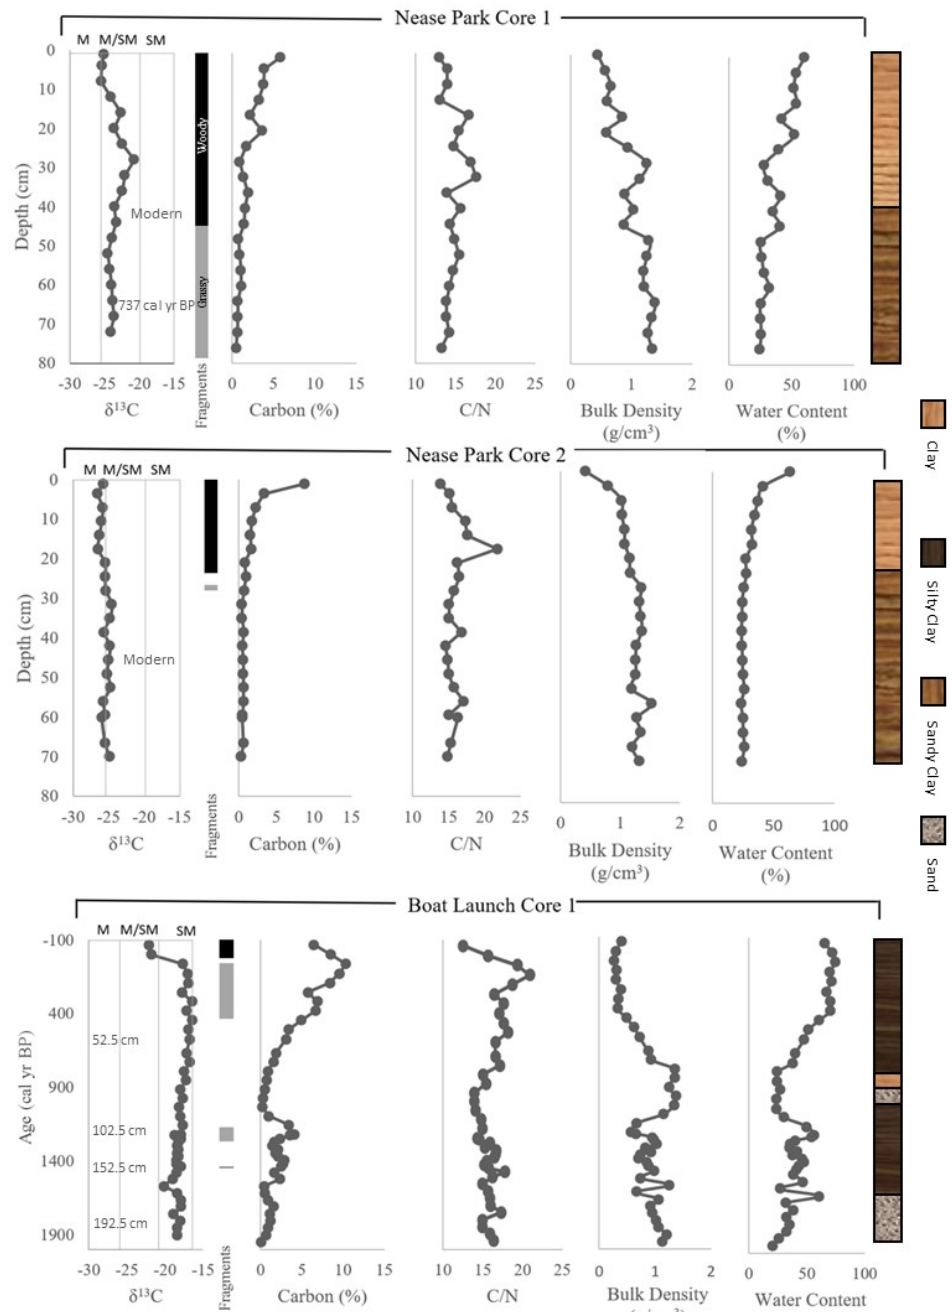
Figure 3. Measured variables (δ 13 C, Carbon Content, C/N ratios, Bulk Density, and Water Content) are presented versus depth for the Nease Park cores and versus age for the Vilano Boat Launch core, where multiple radiocarbon dates allowed development of an age-depth model (negative ages are possible because present = 1950 by convention). The δ 13 C plots include vertical lines indicating δ 13 C values that were only found for mangrove (M) surface samples, salt marsh (SM) surface samples, and the range of overlapping values (M/SM) derived from analysis of surface samples. Presence of identifiable macroscopic fragments from the core description is indicated by black (mangrove woody fragments) and gray (salt marsh grass fragments) bars. Sediment texture for corresponding depth or age is also indicated. Median radiocarbon ages (and modern dates) are indicated at the correct sample depth for both Nease Park cores and sample depths are indicated for the Vilano Boat Launch core where radiocarbon ages were obtained.